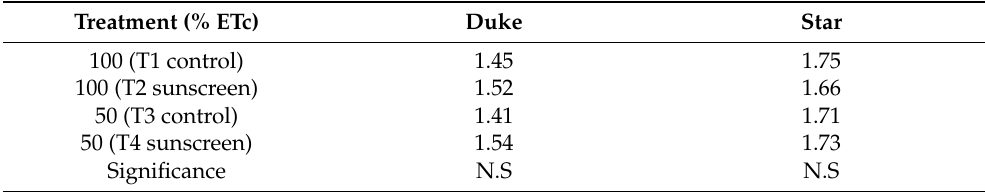
Table 7. Berry weight (g) measured at the first harvest of blueberry plants in the performed treatments on the Duke and Star cultivars.